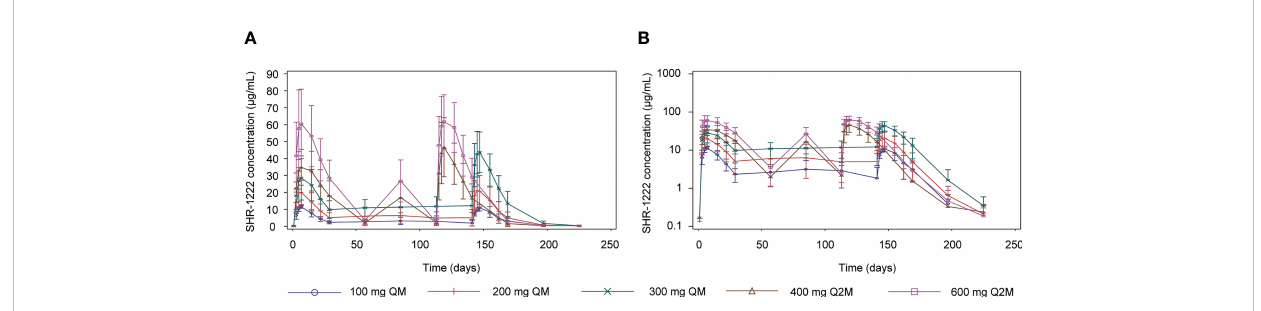
FIGURE 2 Mean serum concentration-time pro fi les of SHR-1222. (A) Linear plots. (B) Semi-log plots. SE, standard error; QM, once every month; Q2M, once every 2